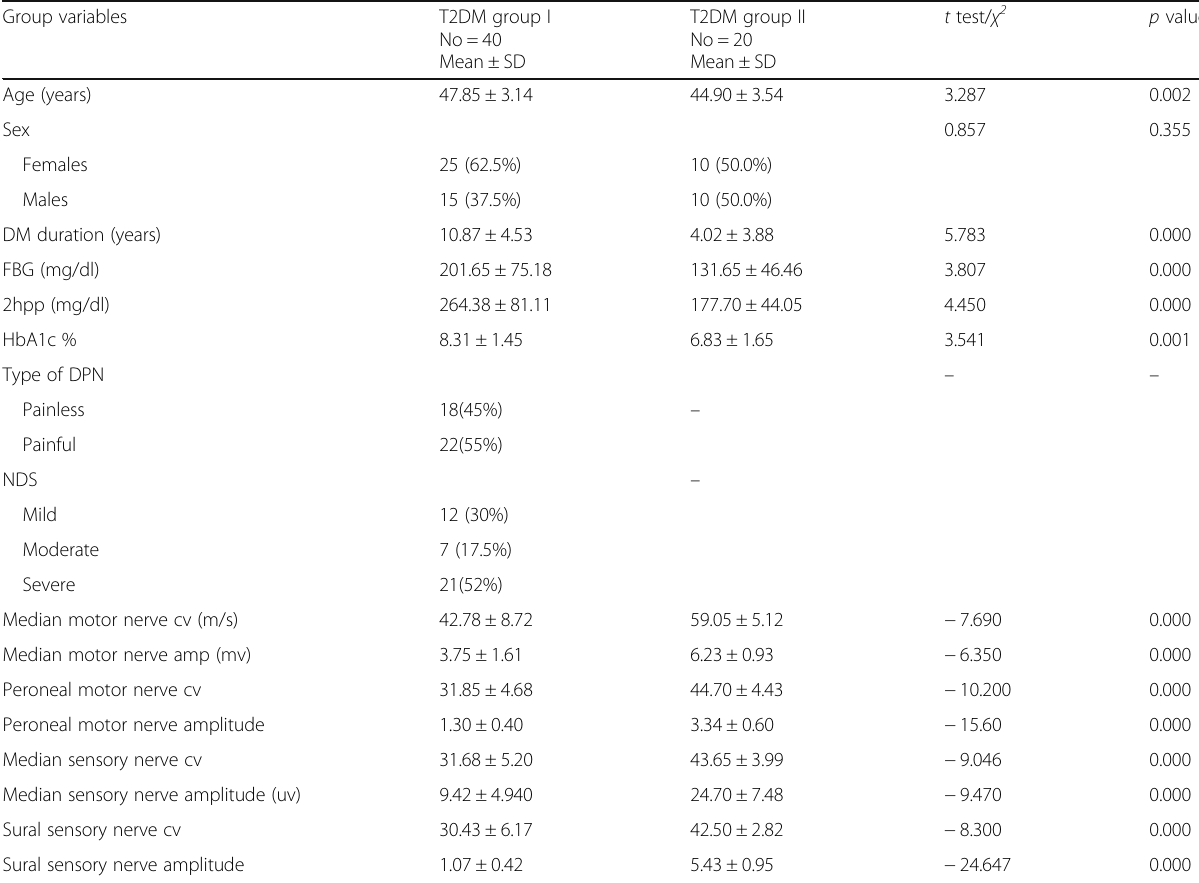
Table 2 Demographic data, laboratory characteristics, and neurophysiological studies of T2DM group I with DPN and group II without DPN Group